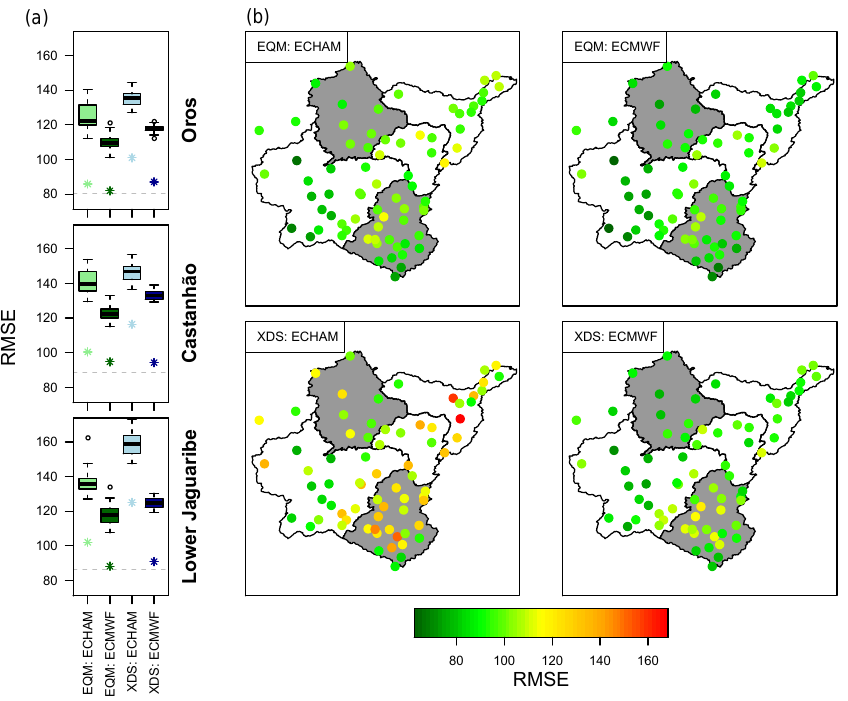
Figure 3. Root mean square error of the forecast of monthly precipitation. Panels (a) : box plots show the spread of the RMSE of each model. The asterisks (*) show the RMSE of the ensemble mean. The RMSE of using climatology as a forecasting product is given by the grey dashed line. The four panels (b) show the RMSE for each individual station for each model. Note that in general the ensemble mean ranks better than the best of the ensemble